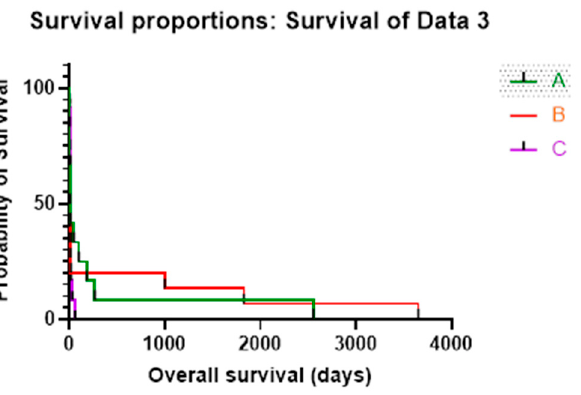
Figure 6. The overall survival in CLIC1 positive cases of LM, divided in three groups (A= d ‐ HGP; B = p ‐ HGP and C = r ‐ HGP).